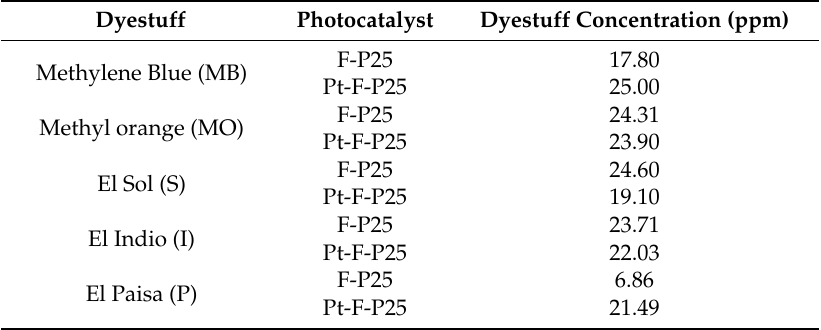
Table 2. Dyestuffs concentration after dark adsorption experiments. Initial concentration 25 ppm.